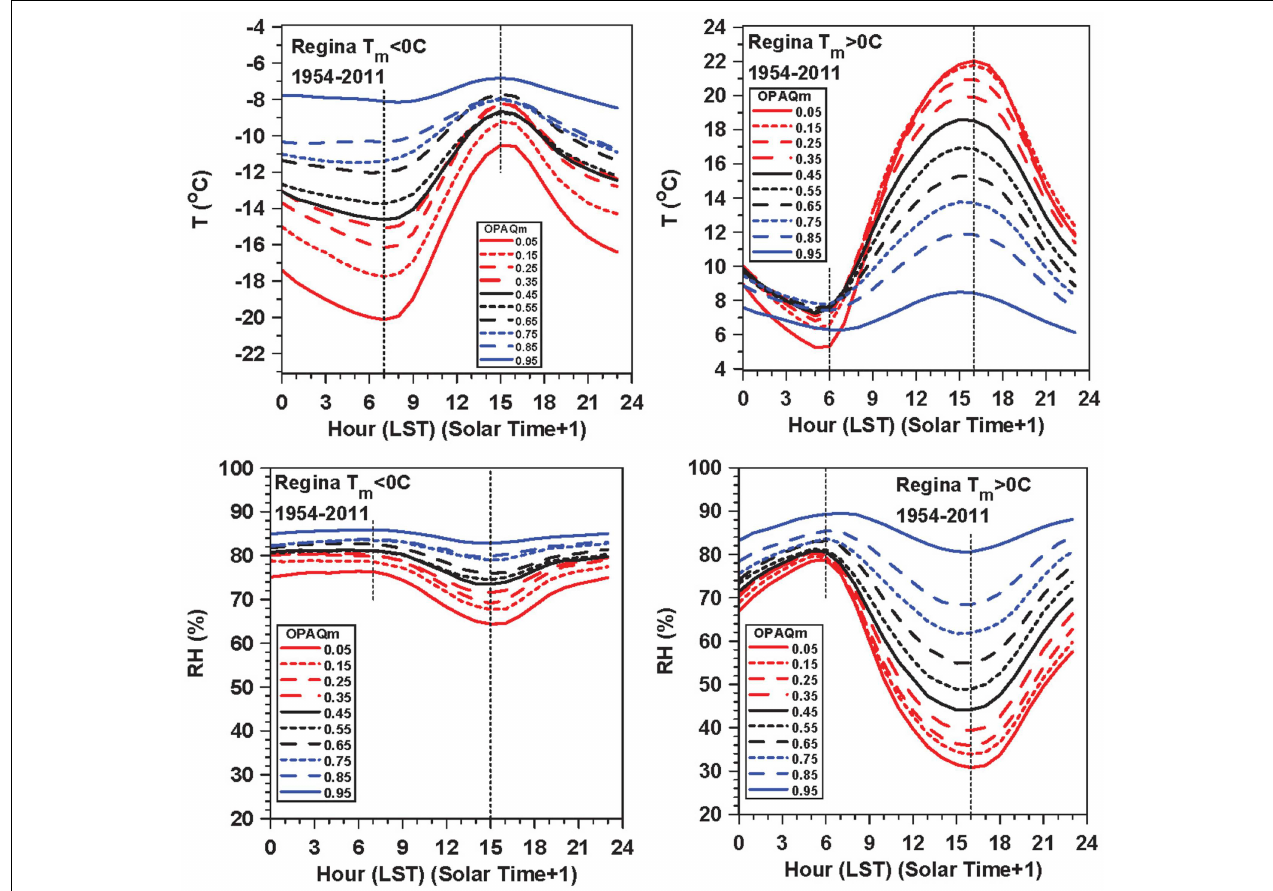
FIGURE 1 | Diurnal cycle of T and RH as a function of opaque cloud, when T m < 0 ◦ C (left) and (right) T m > 0 ◦